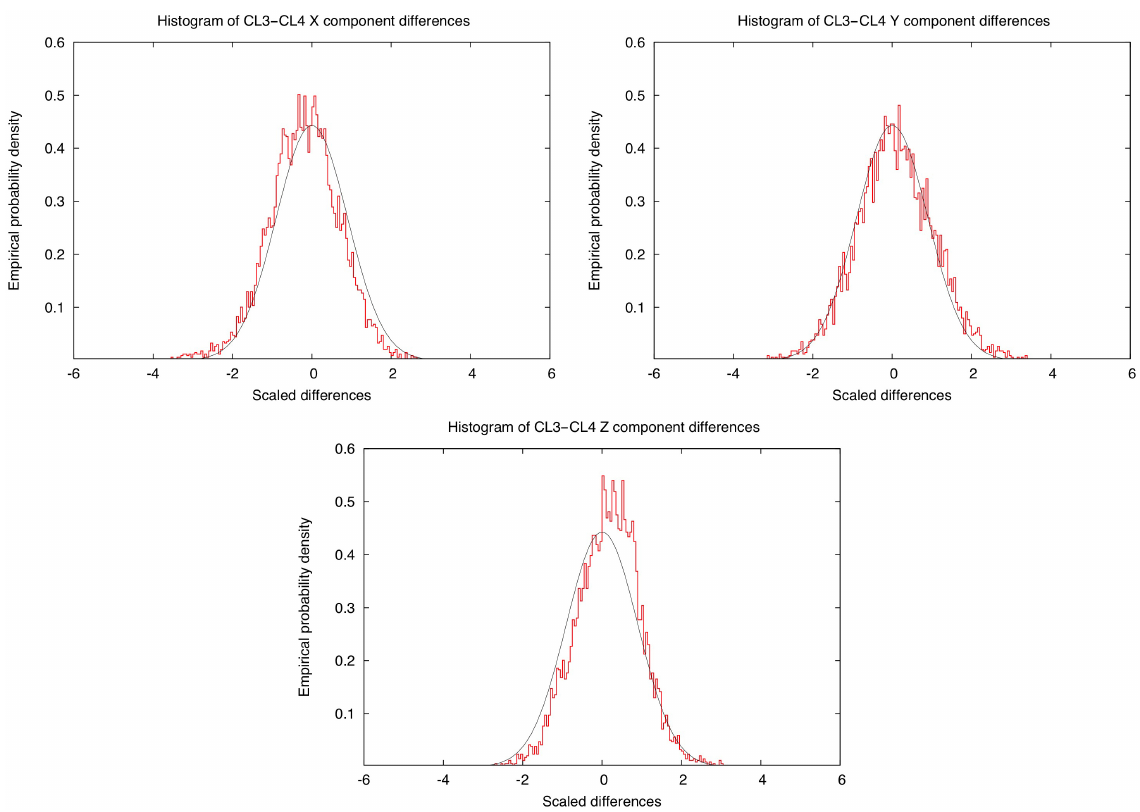
Figure 7. Rescaled histograms of weighted differences between CL3 and CL4 definitive vector data series. The weights used are the inverse of the estimated difference SDs. In black are shown the corresponding Gaussians for a SD of 0 . 9. Note that there are no units here since differences have been divided by their SDs and both are in